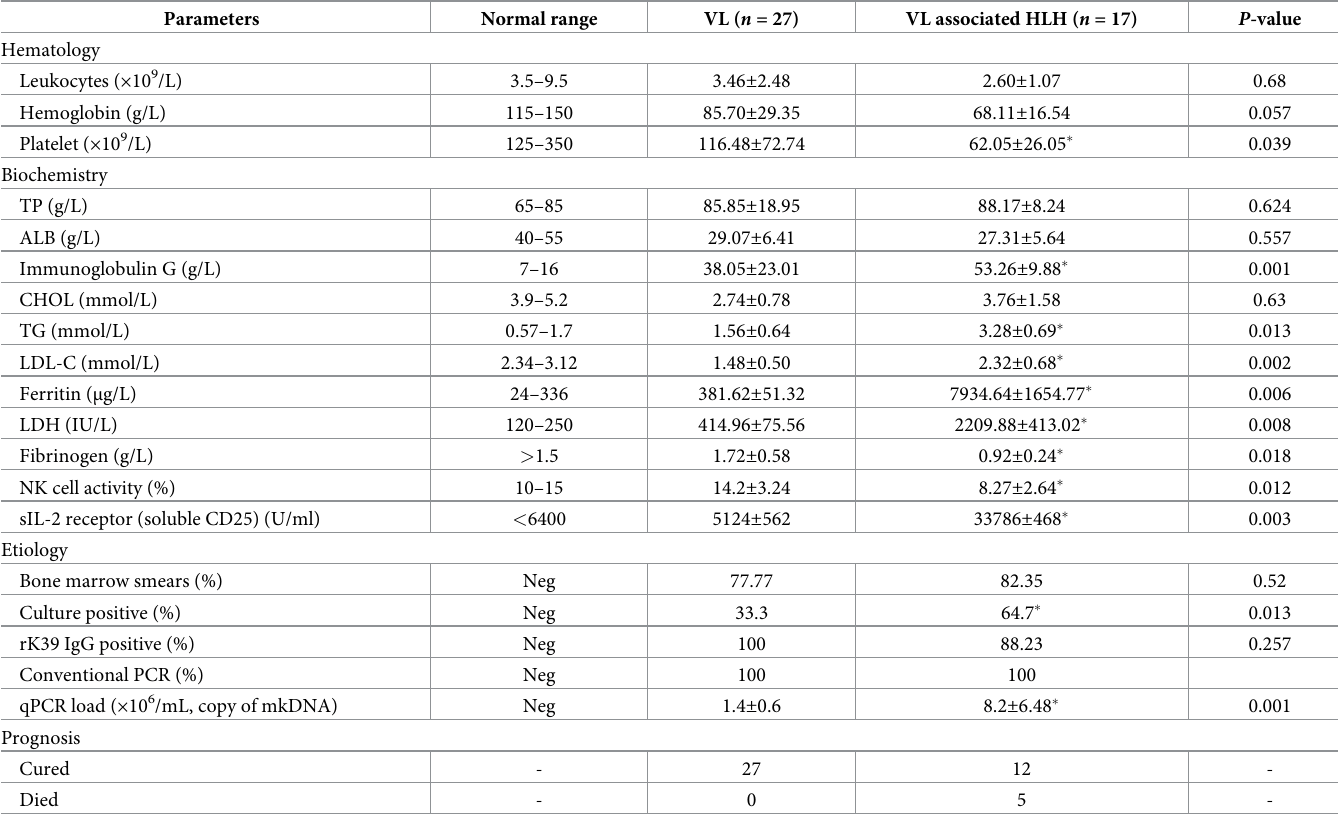
Table 3. Comparison of laboratory tests and prognosis between VL and VL associated HLH